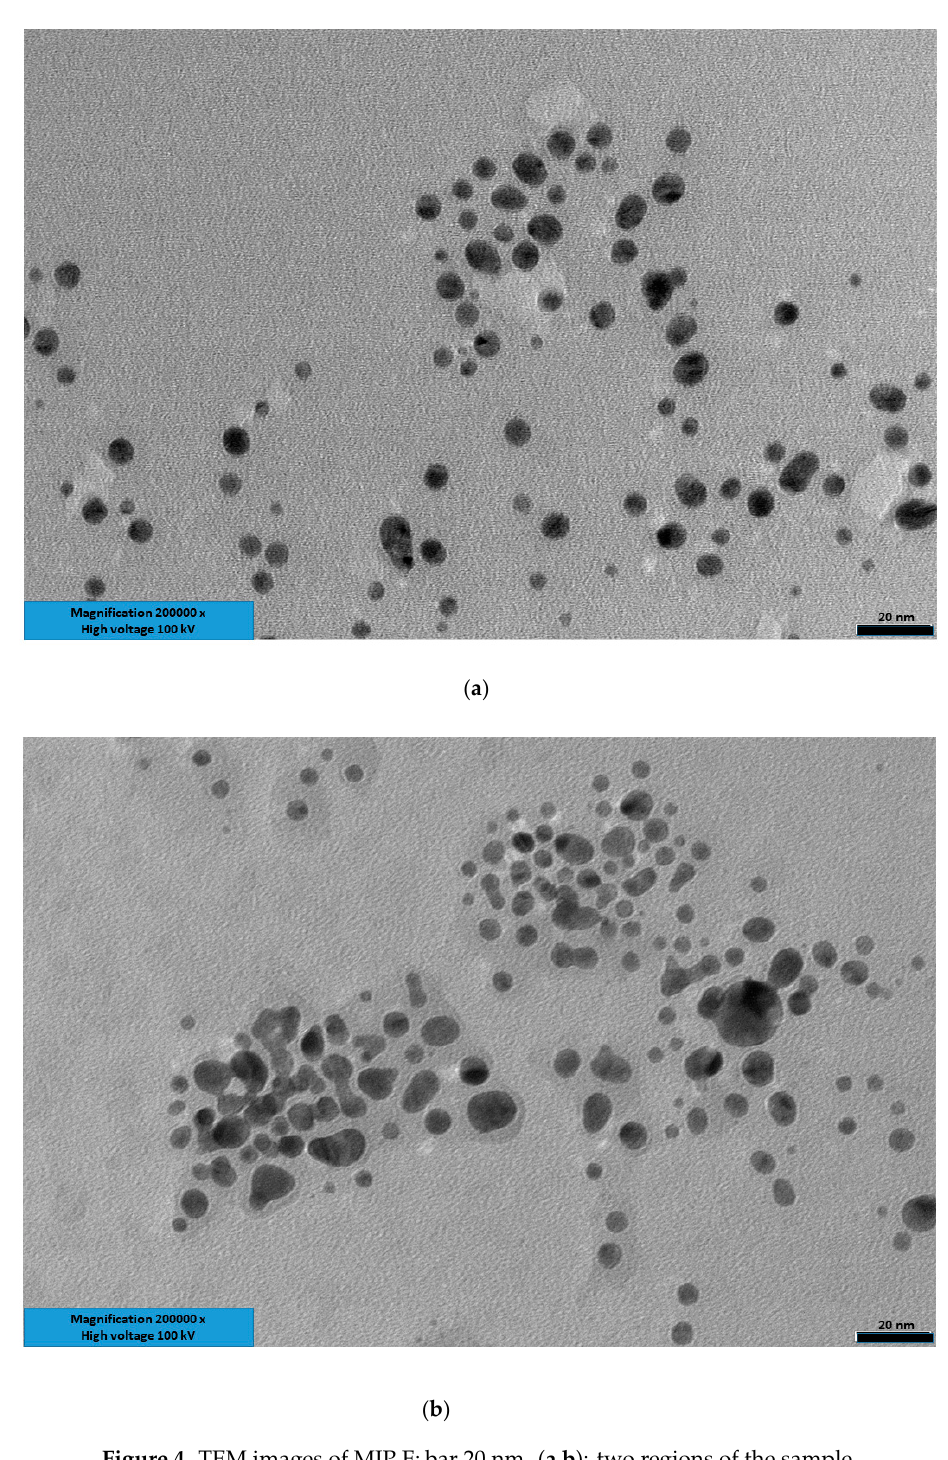
Figure 4. TEM images of MIP F; bar 20 nm. ( a , b ): two regions of the sample